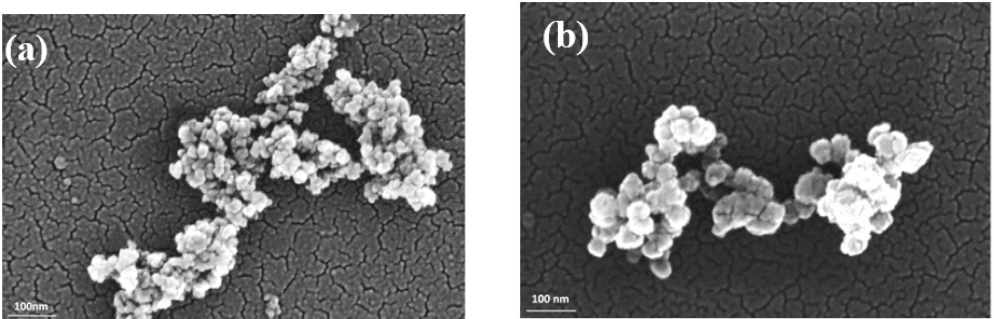
Figure 3. Representative FE-SME images of ( a ) Al 2 O 3 and ( b ) SiC NPs at high magnification.